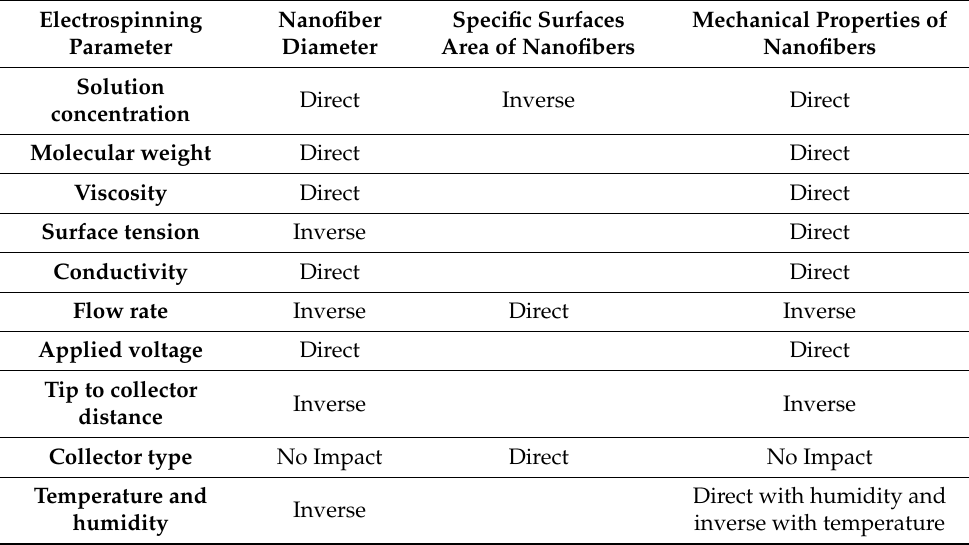
Table 1. Impact of electrospinning parameters on the properties of synthesized